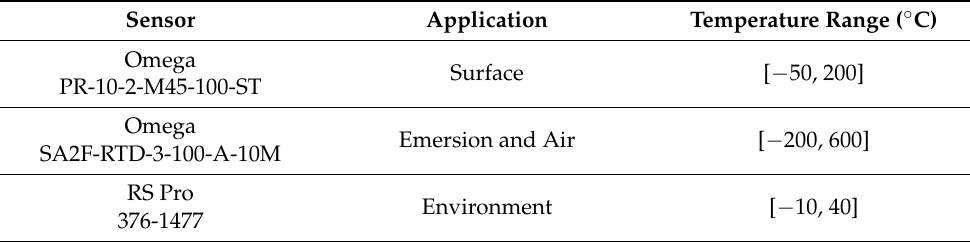
Table 2. Applied